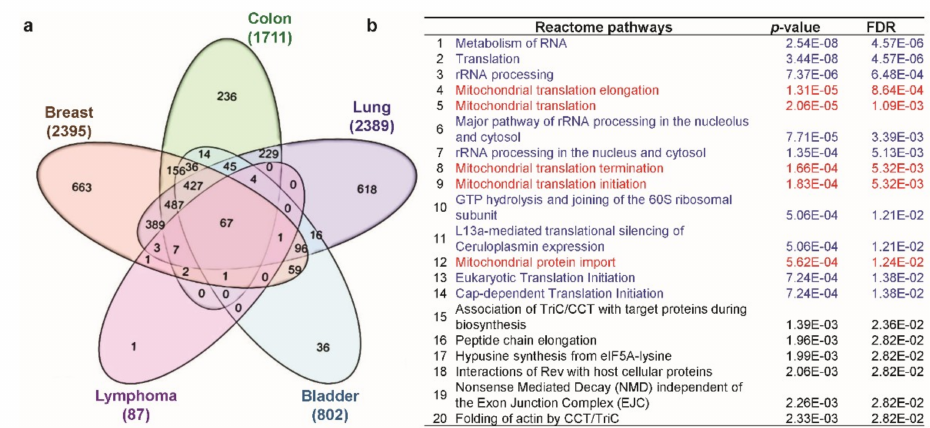
Figure 7. Analysis of positively correlated genes of C1QBP and their predicted pathway analysis using Reactome pathway analysis. ( a ) Venn diagram of genes positively correlated to C1QBP , showing coincident genes in breast, colon, lung, bladder, and lymphoma cancers. ( b ) Pathway analysis using Reactome pathway analysis. Gene ontology (GO) analysis using GOTermFinder functional annotation tool v1.0 is shown in Supplementary Table